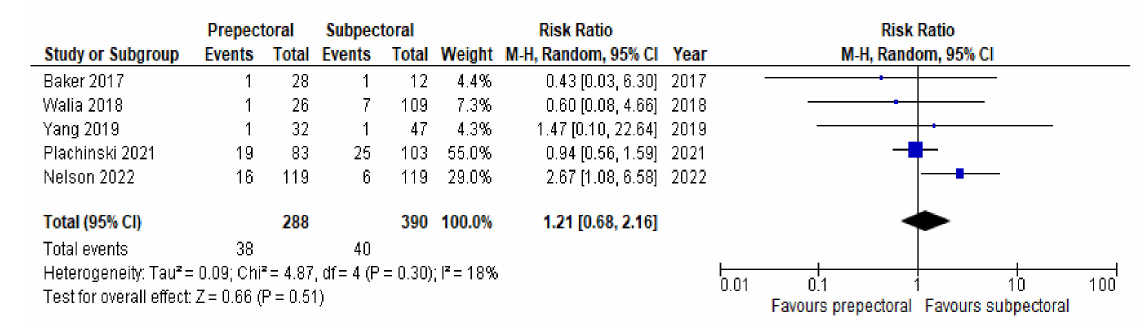
Figure 6. Wound infection [14,16,17,21,22].